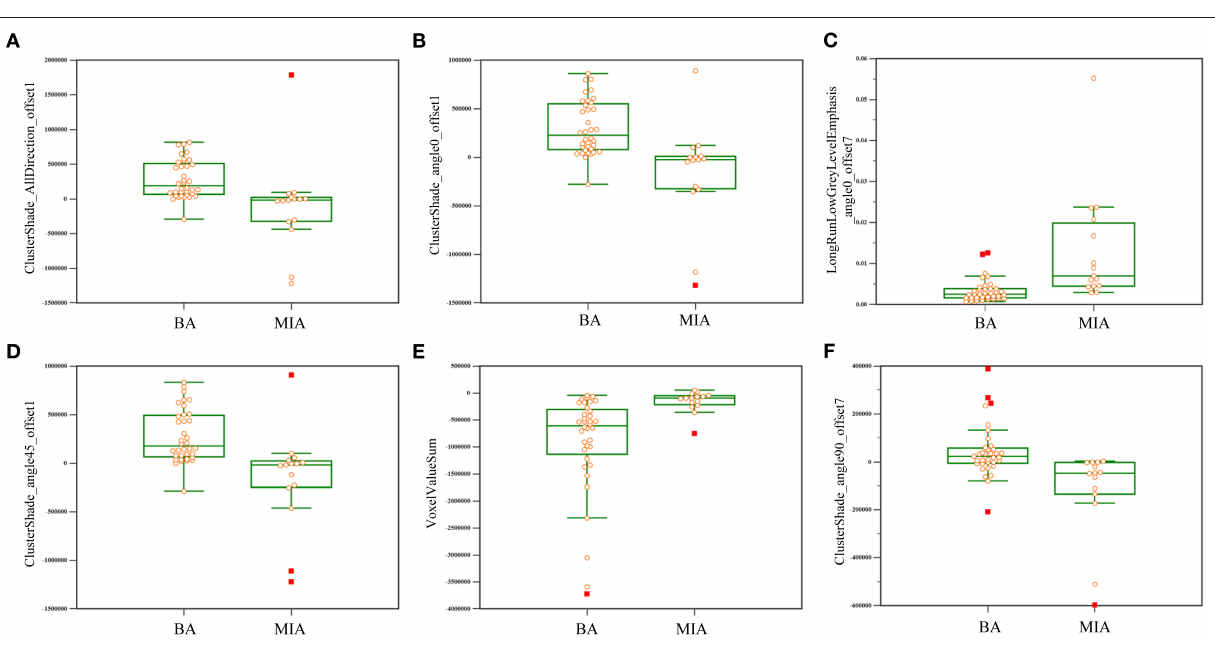
FIGURE 4 | Key texture features showing the most significant difference between BA and MIA. Six features, namely, ClusterShade_AllDirection_offset1 (A) , ClusterShade_angle0_offset1 (B) , LongRunLowGreyLevelEmphasis_angle0_offset7 (C) , ClusterShade_angle45_offset1 (D) , VoxelValueSum (E) , and ClusterShade_angle90_offset7 (F) , varied significantly between BA and MIA on thin-section unenhanced CT